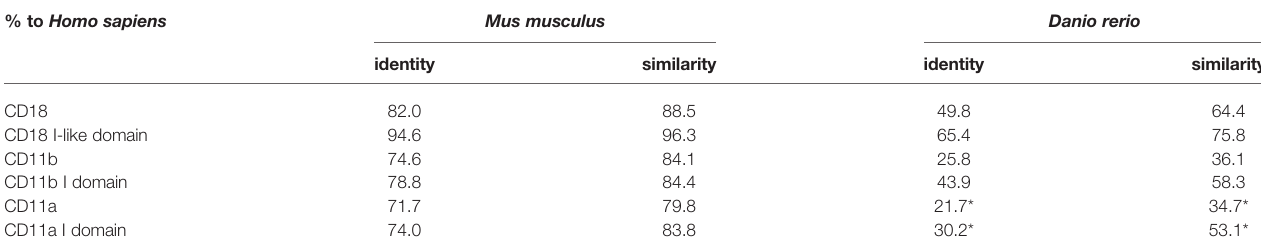
*Zebra fi sh CD11b was aligned to human